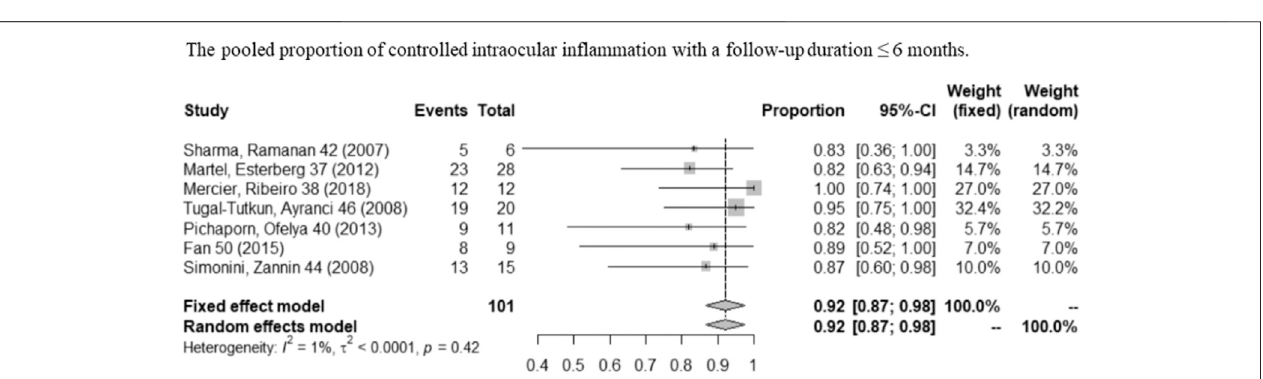
FIGURE 3 | Pooled proportion of controlled intraocular in fl ammation with a follow-up duration of ≤ 6 months.